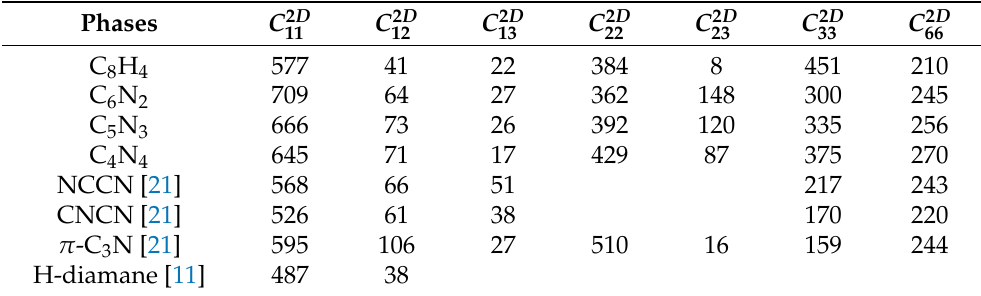
Table 2. The two-dimensional (2D) elastic constants of four phases of W-diamanes are reported in N/m unit by comparing with those of other 2D sp 3 carbons and carbon nitrides.